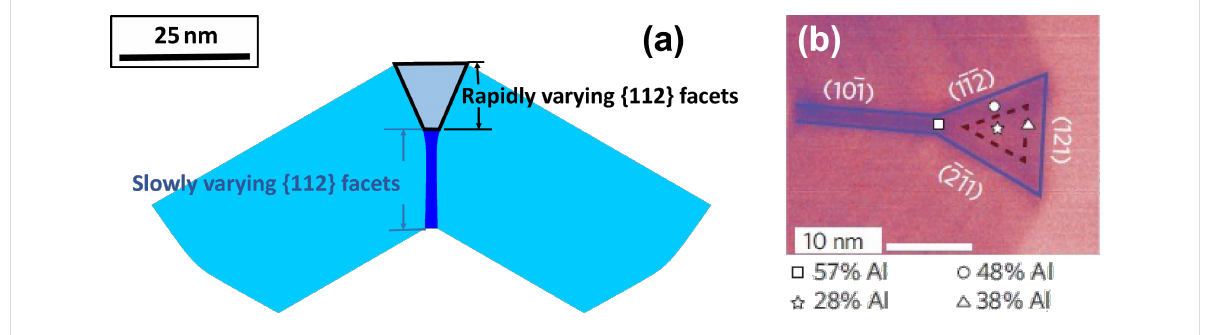
Figure 7: (a) This is partial view of a cross section of the shell of core–shell nanowire with one {112} facet along the corner of two neighboring {110} facets. (b) Detail of a Al-poor quantum dot located within the fork-like Al-rich stripes obtained in